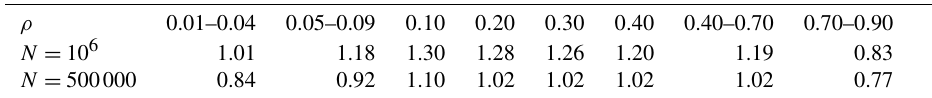
Figure A1. Comparison of RC–ESN forecasting skills with nonlinear transformation algorithms T 1 , T 2 , and T 3 (cyan, green, and blue lines, respectively) and without any transformation (red line). Black line shows the truth. (a) Predictions from one initial condition and (b) relative L 2 -norm error averaged over 100 initial condition e(t) (Eq. 8). Time is in MTU, where 1MTU = 200 (cid:49)t ≈ 4 . 5 /λ max . Table B1. Prediction horizon (MTU) over 100 initial conditions for an RC–ESN with samples sizes of N = 10 6 , N = 500000, and D = 5000 for different ranges of ρ